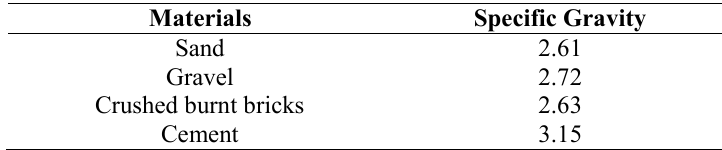
Specific gravity of constituent